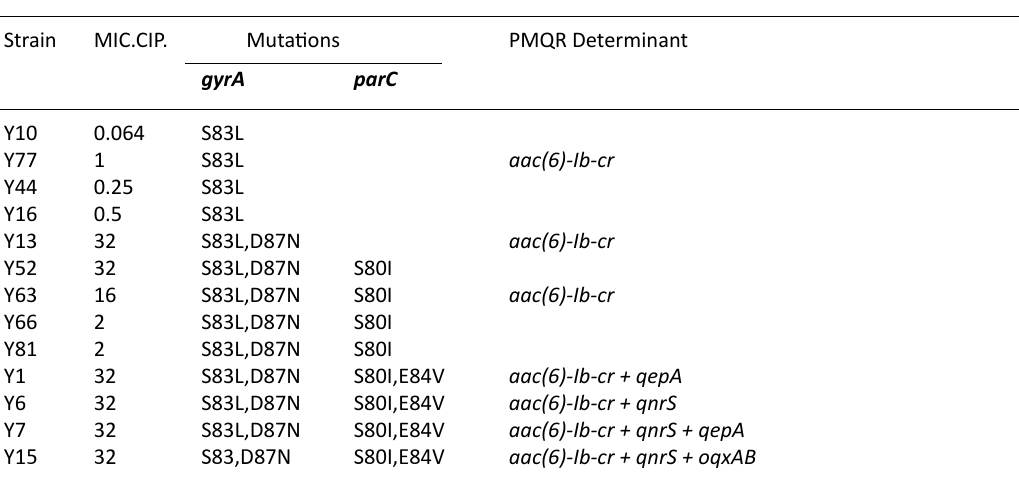
Table 4. Results of the sequencing of QRDR of selected isolates Strain